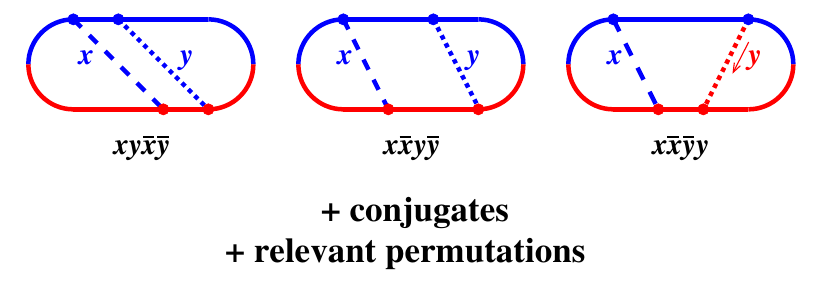
Figure 1 . \Crossed" time-ordered diagrams for the real double gluon splitting rate. Labeling of diagrams ( xy (cid:22) y (cid:22) x , etc.) is as in ref. [25]. All lines in this and other (cid:12)gures represent high-energy gluons.